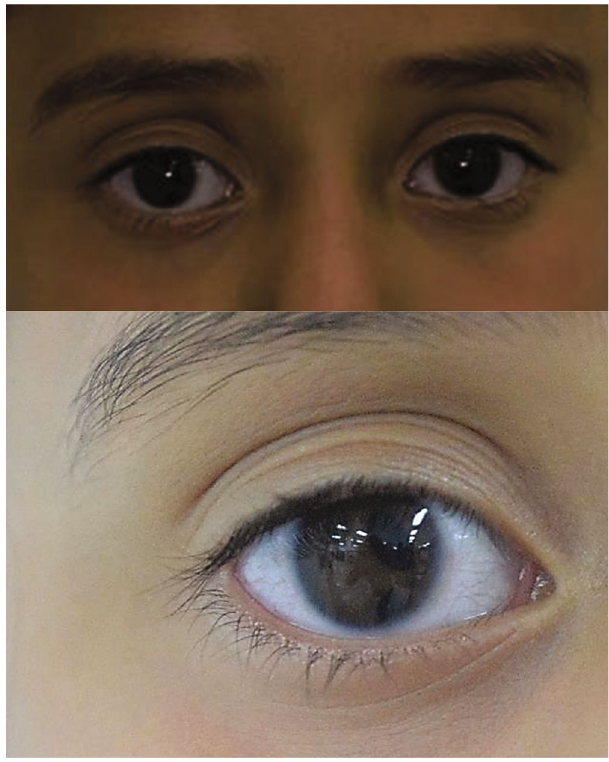
Figure 1: Evidence of pupillary dyscoria.